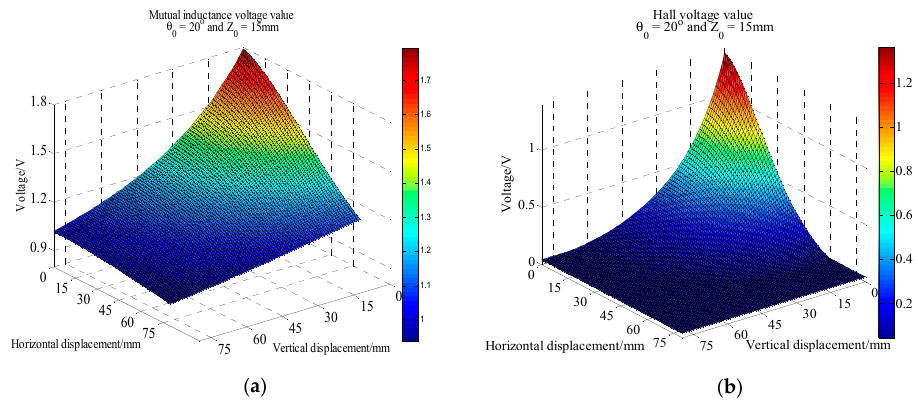
Figure10. Voltage acquisition data at 20 ◦ inclination. ( a ) Mutual inductance voltage; ( b ) Hall voltage.